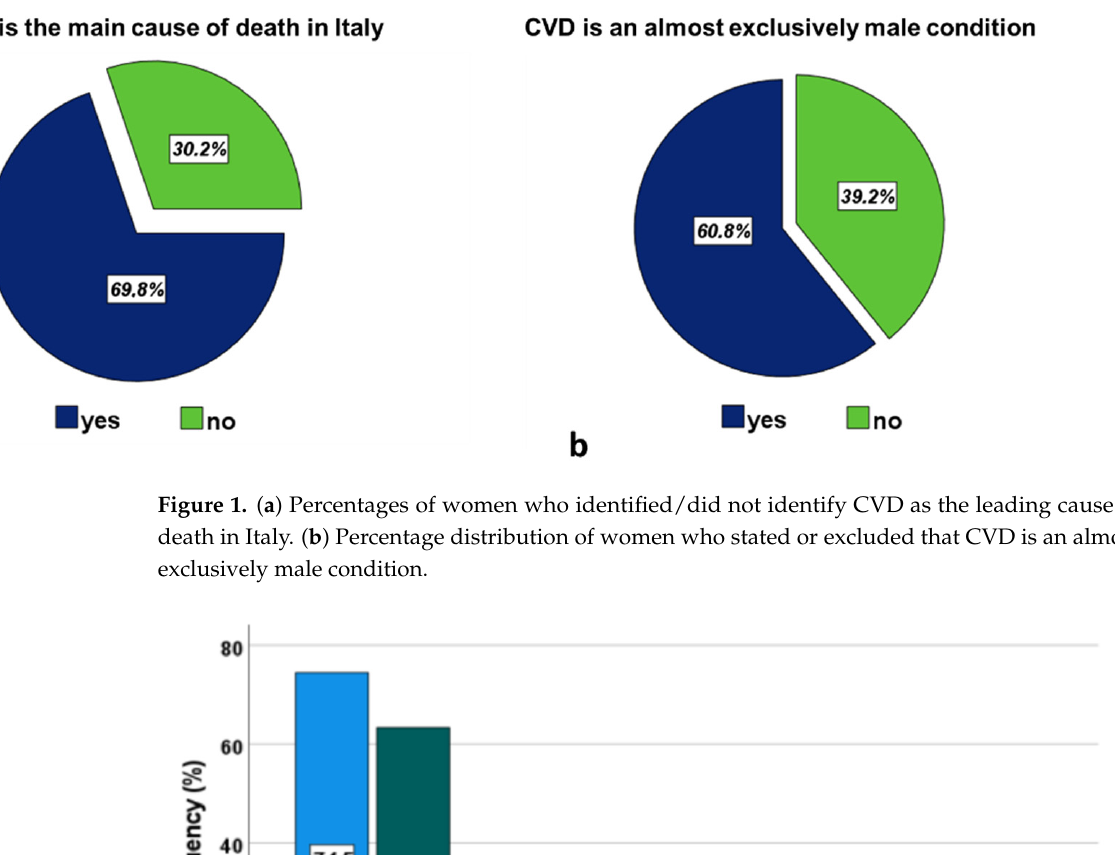
Figure 1. ( a ) Percentages of women who identified/did not identify CVD as the leading cause of death in Italy. ( b ) Percentage distribution of women who stated or excluded that CVD is an almost exclusively male condition.